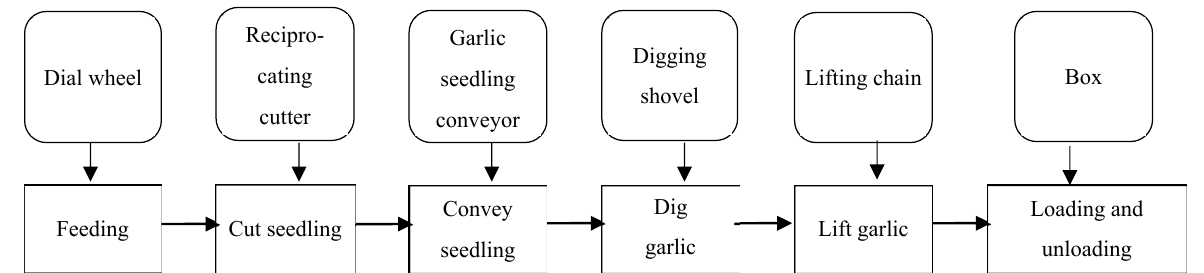
Figure 2. Block diagram of working principle of garlic combine harvester of cut–dig type under 4DS-1200 model.